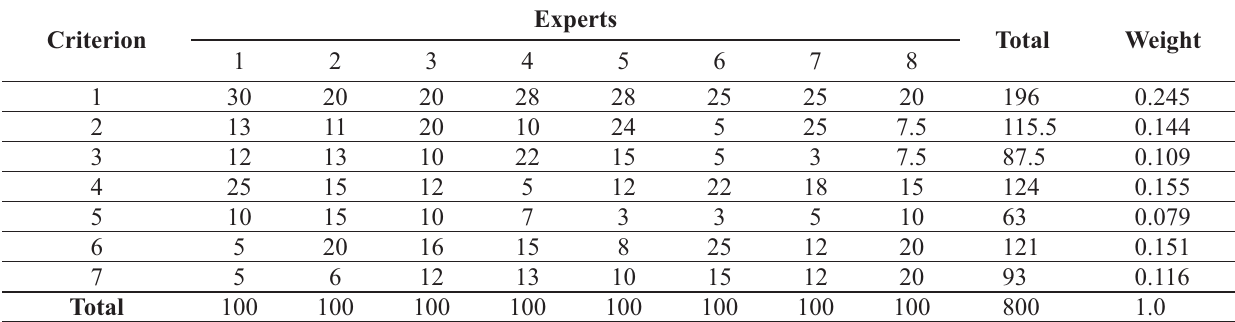
Table 2 . Expert estimates of Group 1 criteria weights